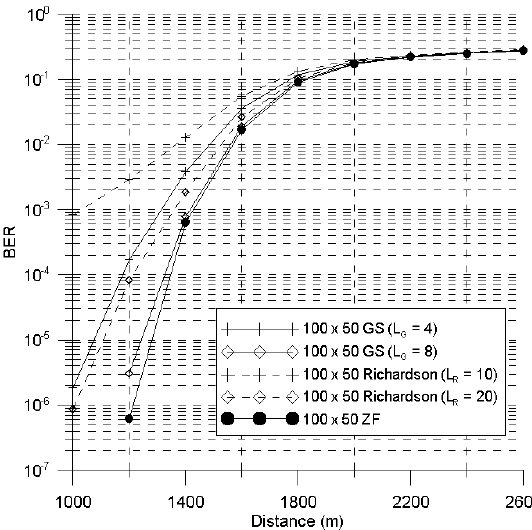
Figure 6. The BER performances for for GS pre-coding, Richardson pre-coding and ZF pre-coding in a 100 × 50 system with respect to distance between the BS and users when an initial solution is s ( ) 0 and 16-QAM is used. NS,Stair